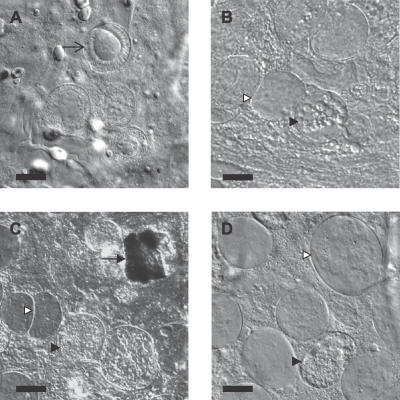
Oocyst Morphology of wt and Δpblap ParasitesDifferential interference contrast images of wt day 21 p.i. (A), Δpblap2 day 13 p.i. (B), Δpblap4 day 18 p.i. (C), and Δpblap6 day 21 p.i. oocysts (D) in An. stephensi. Most wt oocysts have undergone sporulation (open arrow). No sporozoite formation is observed in Δpblap infections, and oocysts appear either immature/enlarged (open arrowhead) or degenerate/vacuolated (closed arrowhead). Some Δpblap4 oocysts are melanized (closed arrow). Scale bar = 20 μm.